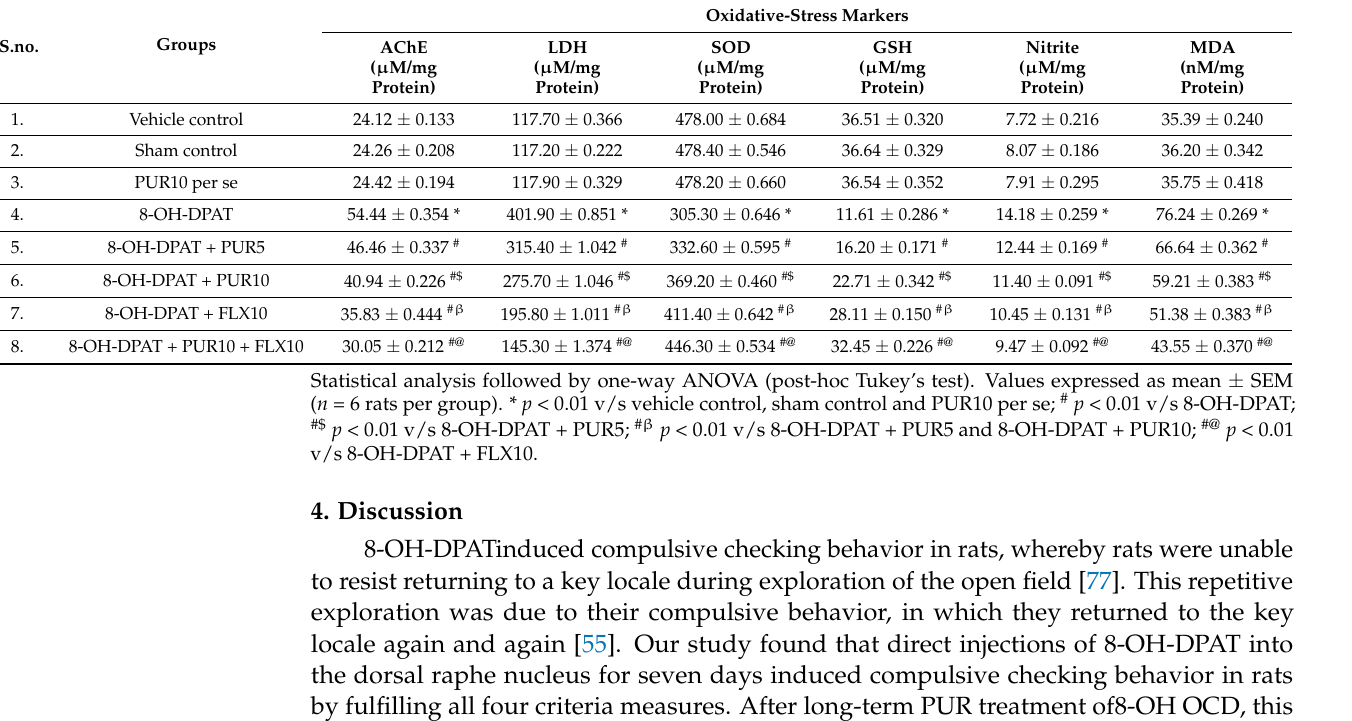
Table 5. Effect of purmorphamine on oxidative-stress-marker levels in 8-OH